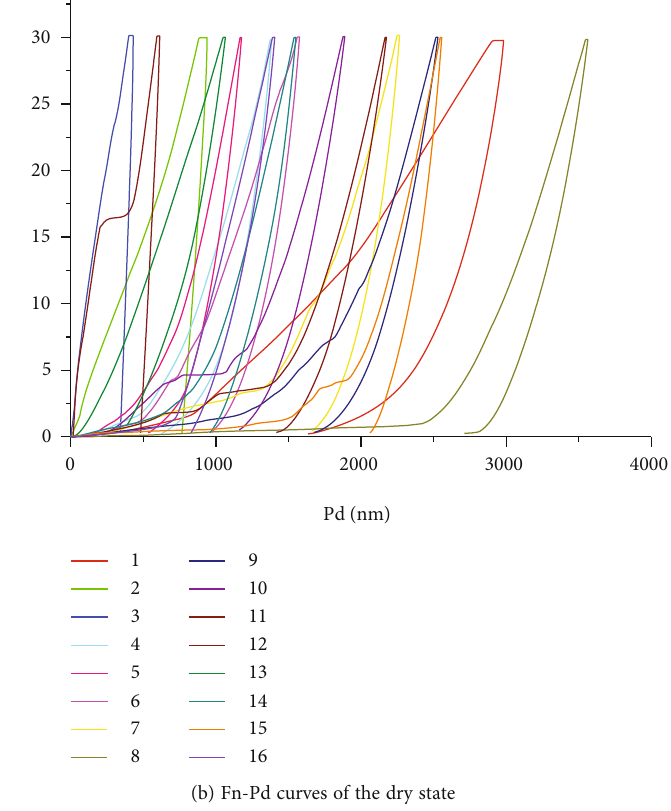
(b) Fn-Pd curves of the dry state Figure 7: